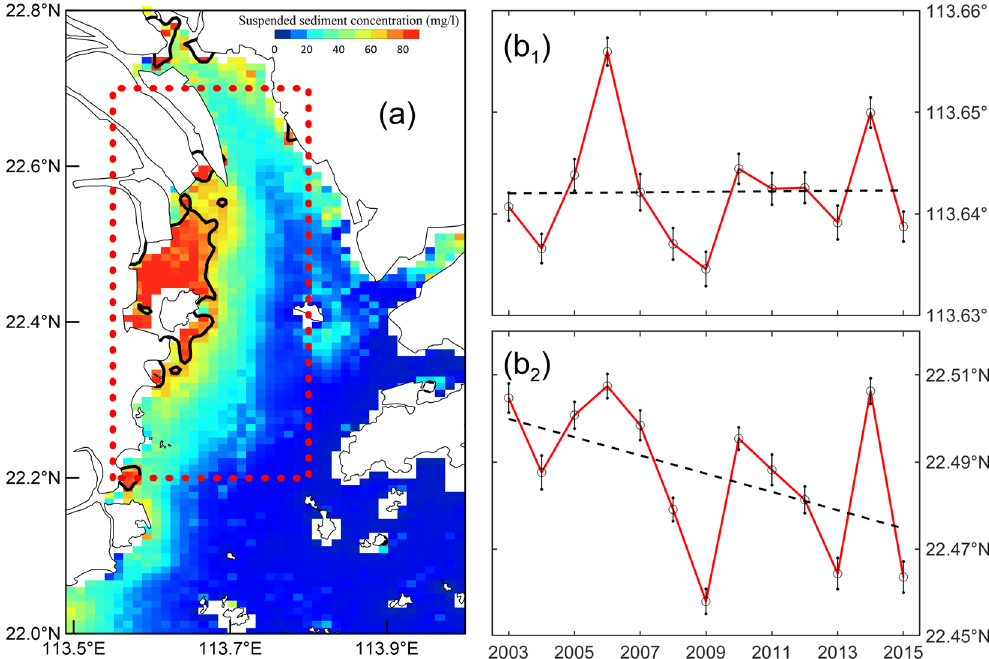
Figure 6. The distribution of SSC and the location of the zone where the quantile of SSC was greater than 90th in Lingding Bay of PRE in the wet season of 2015 ( a ). The Migration trend of this zone in the longitude and latitude directions from 2003 to 2015 ( b ). The black bold solid line in ( a ) represents the 90th isoline of the quantile of SSC. The black circles, error bars and dashed lines in ( b ) represents the annual wet season SSC, the corresponding 95% confidence interval and the linear regression trend, respectively. It can be summarized from ( b ) that the maximum SSC zone of the Lingding Bay did not generally shift westward during 2003–2015,